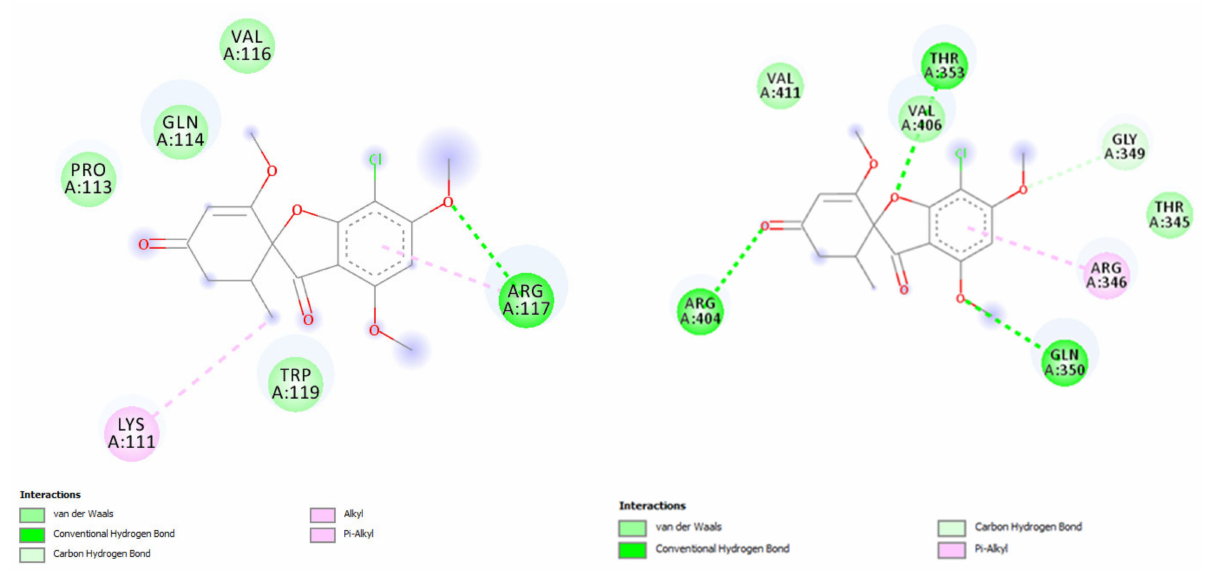
Figure 3. 2D binding model of griseofulvin docked into the active site of keratin 18 (K18) in mouse ( left ) and rat ( right ). The dotted lines show the key interacting residues of the K18 toward griseofulvin as a ligand. The green, light green, and pink dotted lines show conventional hydrogen bonds, van der Waals, alkyl or Pi-alkyl interactions, respectively.